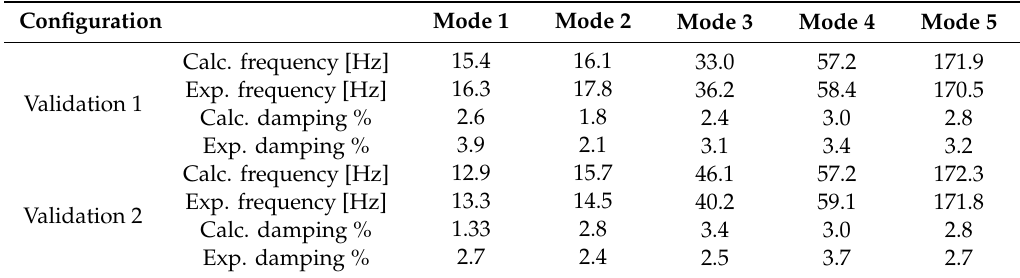
Table 4. Validation